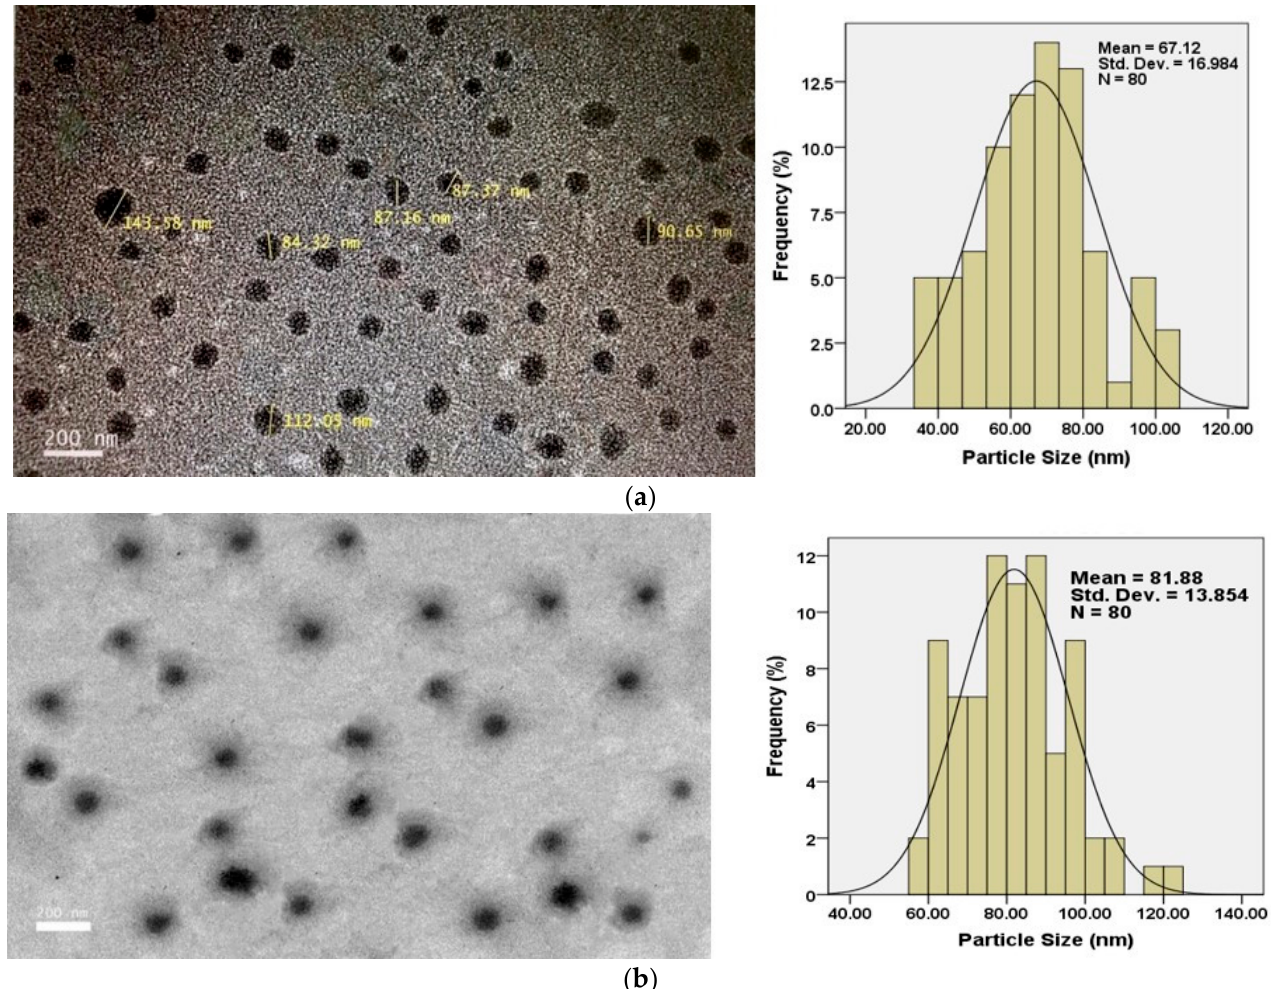
Figure 8. HRTEM micrographs of ( a ) Sorafenib-loaded chitosan nanoparticles (SF-CS) and ( b ) folate-conjugated, Sorafenib-loaded chitosan nanoparticles (SF-CS-FA).